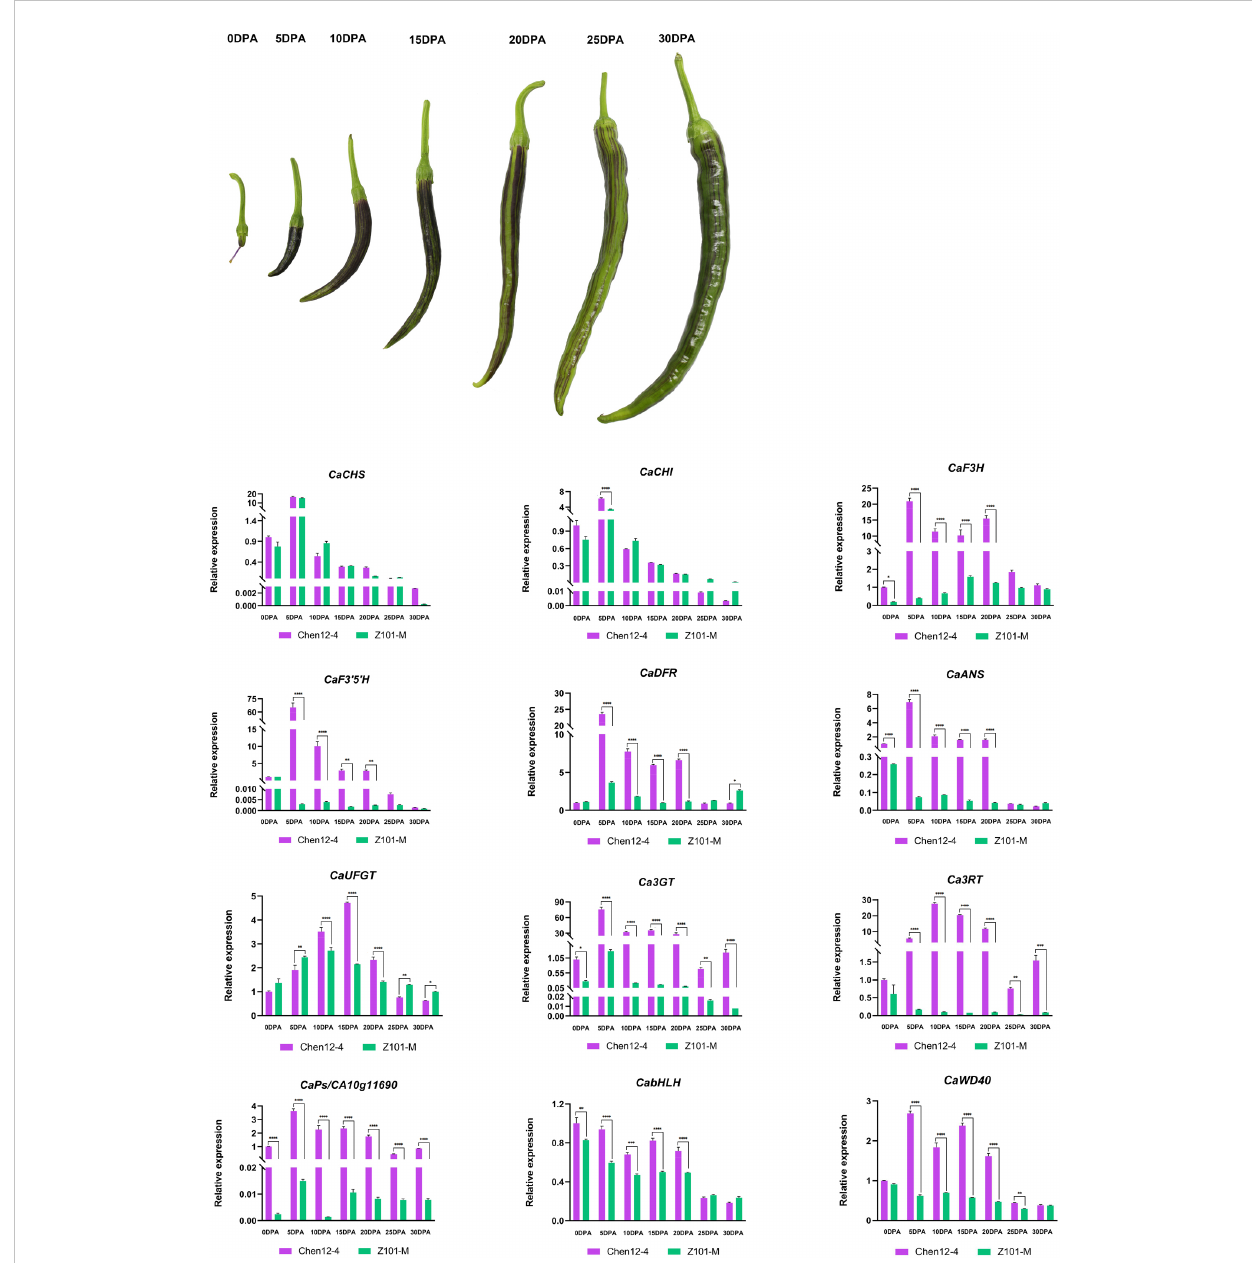
FIGURE 5 Expression analysis of CA10g11690 and other anthocyanin biosynthesis genes in two parents at differernt development stages. 0DPA, ovary at anthesis; 5 DPA, young fruit at 5 days post-anthesis; 10 DPA, young fruit at 10 days post-anthesis; 15 DPA, young fruit at 15 days post-anthesis; 20 DPA, young fruit at 20 days post-anthesis mature; 25 DPA, young fruit at 25 days post-anthesis; 30 DPA, young fruit at 30 days post-anthesis. The signi fi cant differences were identi fi ed using T-test, asterisks indicate a signi fi cant difference. ****P<0.0001, ***P<0.001, **P<0.01,